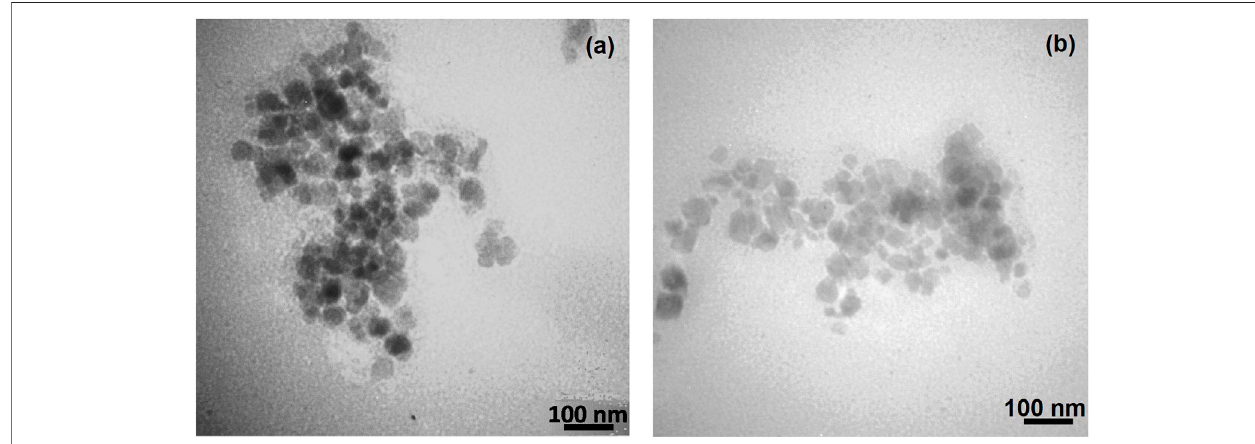
FIGURE 5 | TEM images of synthesized Fe 3 O 4 @SiO 2 @Tannic acid MNPs: (a) after one cycle of reaction; (b) after six cycles of reaction.